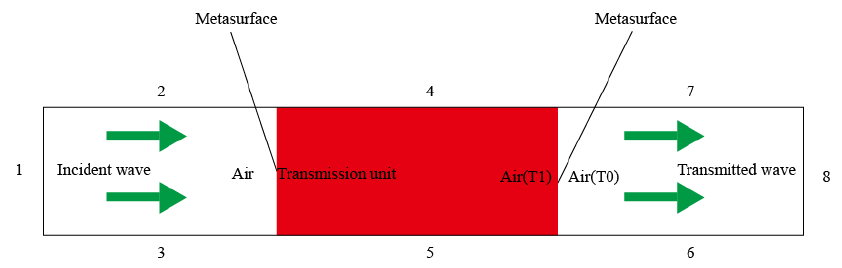
Figure 2. Schematic diagram of transmission unit.